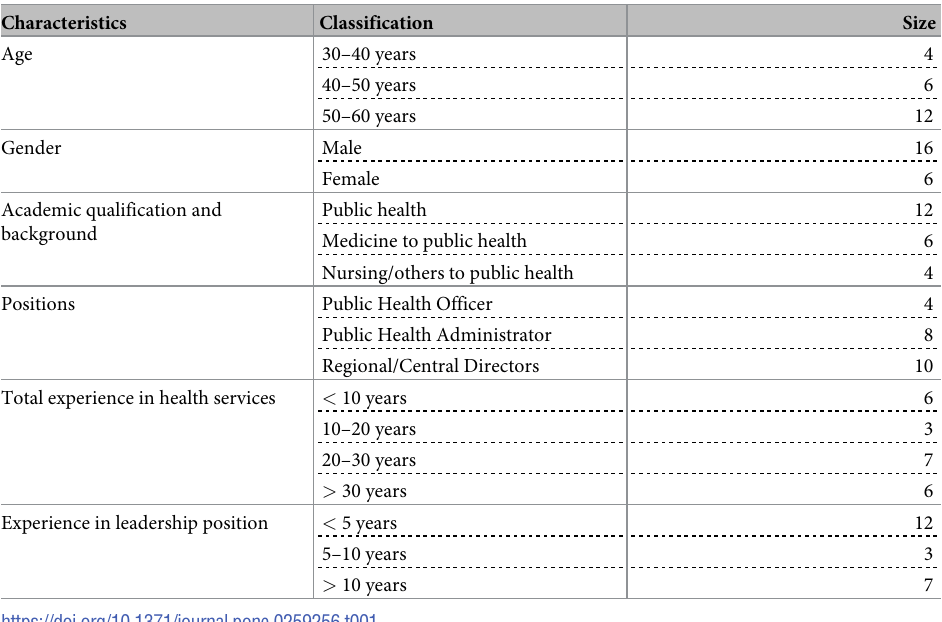
Table 1. Participants’